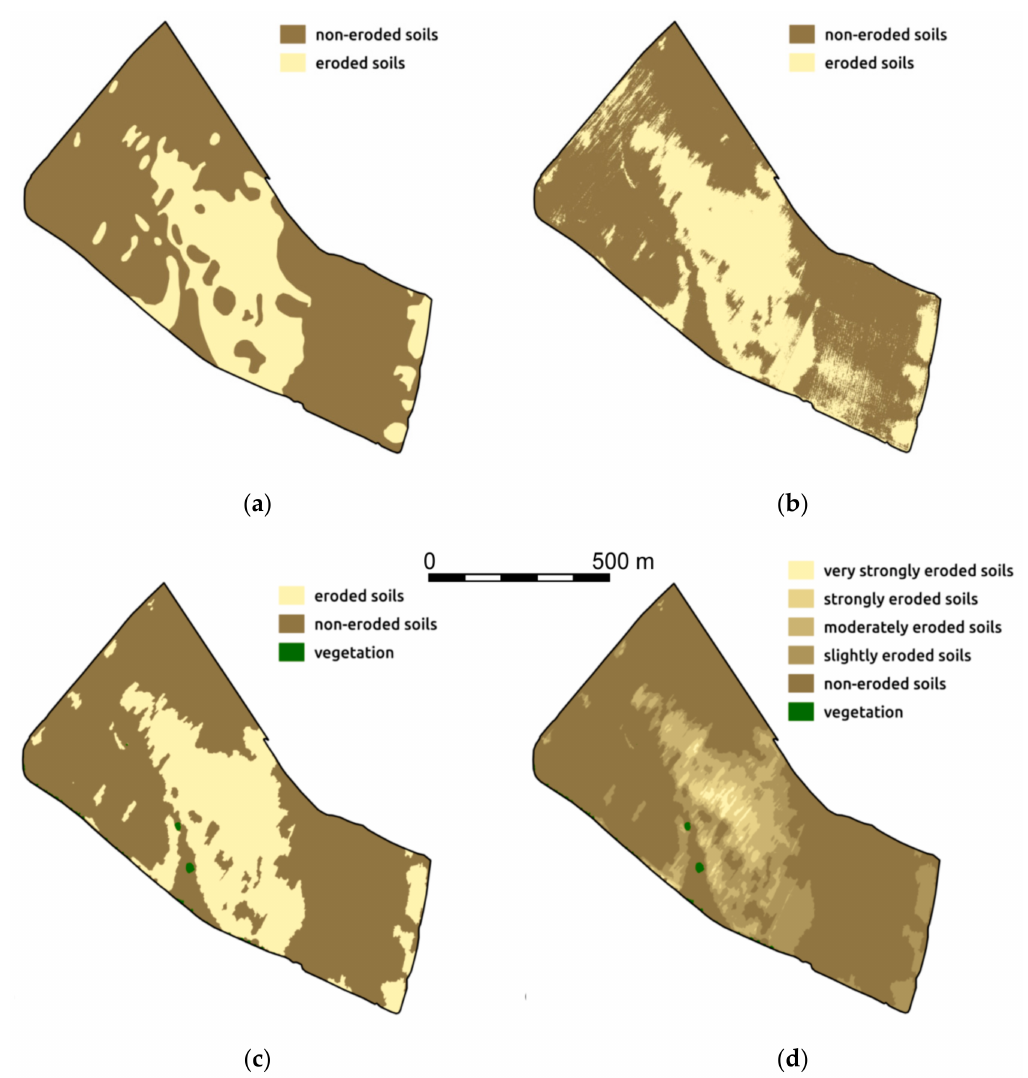
Figure 2. Comparison of erosion patterns obtained by di ff erent methods: visual interpretation ( a ), pixel-based classification ( b ), object-based classification ( c ) with two erosion categories and ( d ) with five erosion categories used for comparison with the modelled erosion